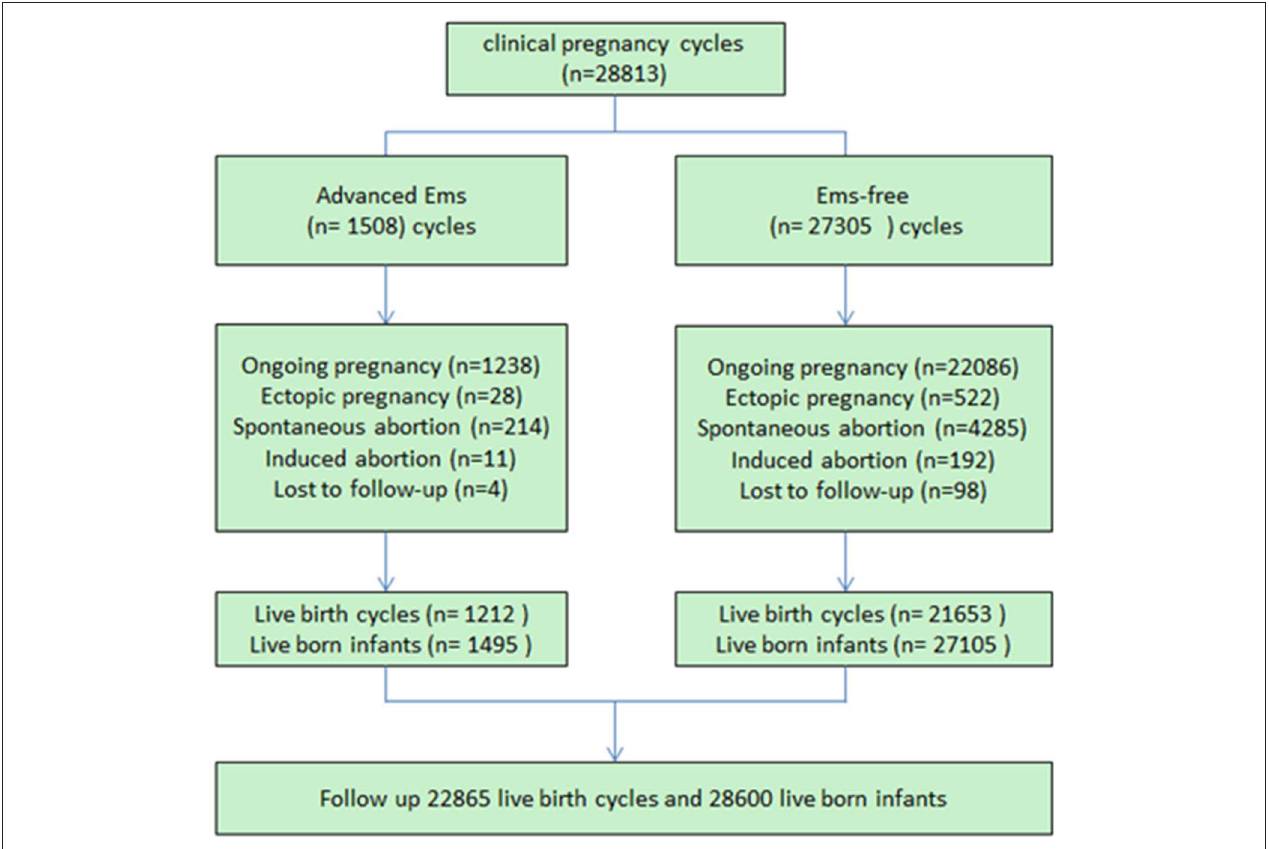
FIGURE 1 | Flow chart of the